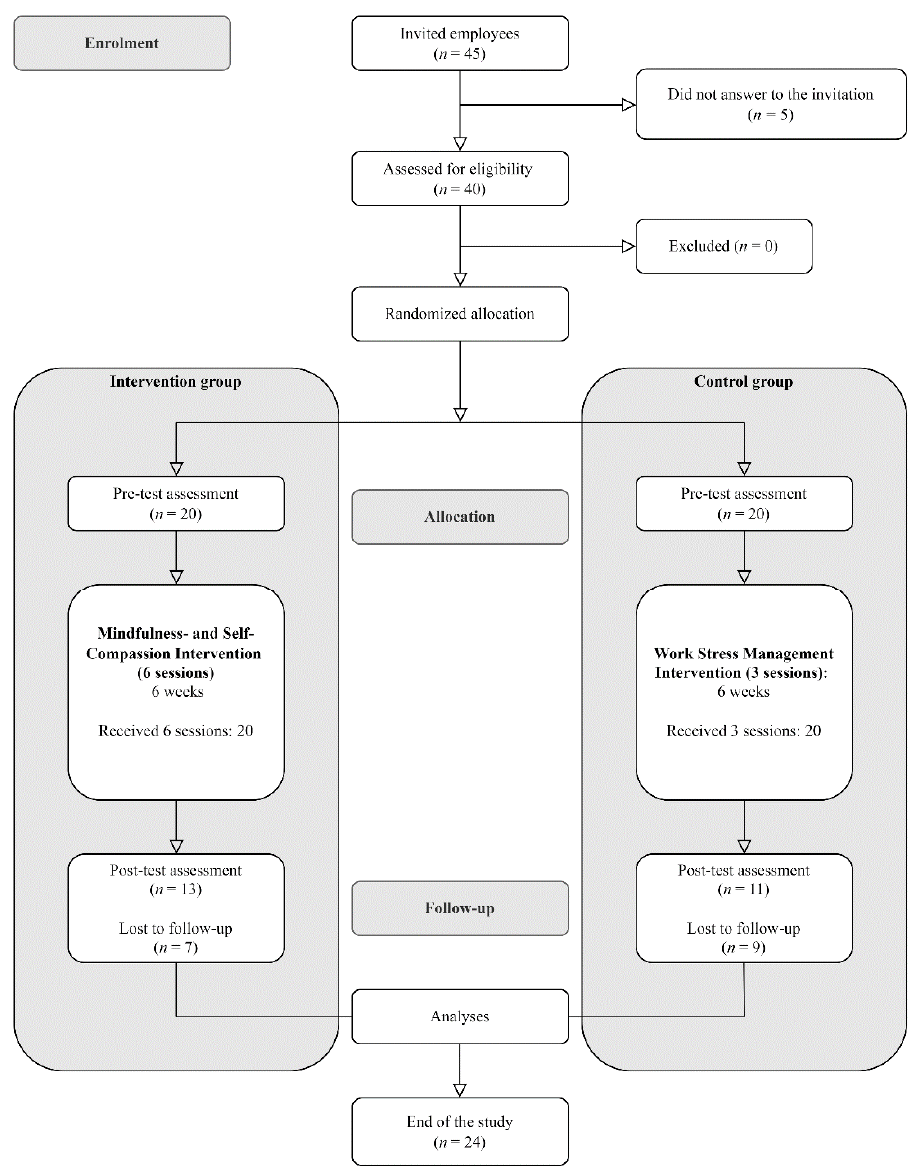
Figure 1. Flow of participants through the trial.